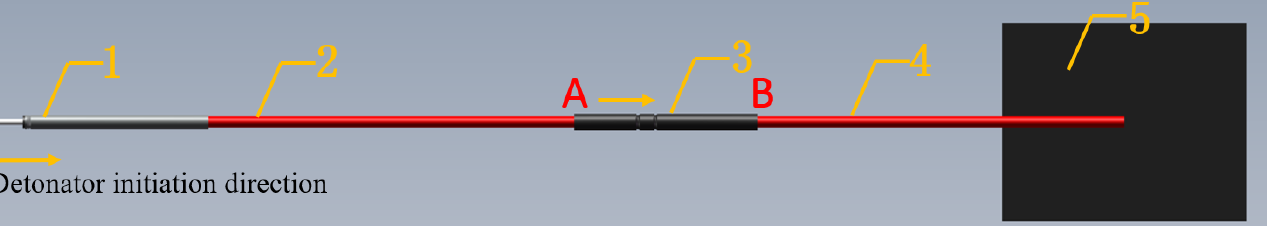
Figure 4. Configuration of the detonation propagation experiment, 1 — detonator, 2 — detonating cord of end A, 3 — explosive diode, 4 — detonating cord of end B, 5 — the thickness of 0.2 mm iron-plate.